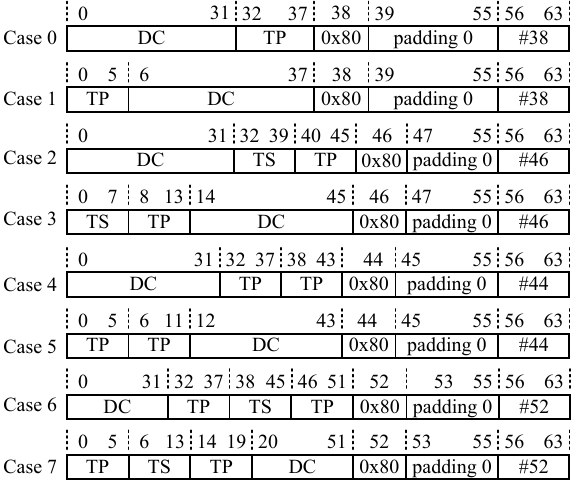
Figure 4: The 8 block generation patterns of loop5 when LP = 6 bytes and LS = 8 bytes. The numbers marked on each segment represent its position in the